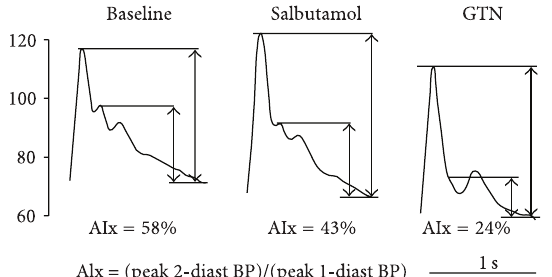
Figure 2: An example of the e ff ect of salbutamol and glyceryl trinitrate (GTN) on the radial waveform in a single individual. The second systolic peak, obvious at baseline, is attenuated by salbutamol and almost completely abolished following GTN. Augmentation index (AIx), calculated as the ratio of the pulse pressure at the second systolic peak to that at the first systolic peak is used to quantify the changes in the waveform. BP = blood pressure. Printed with permission from